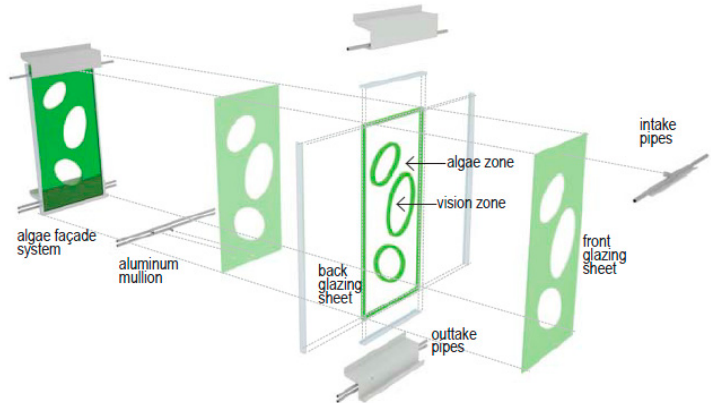
Figure 3. Algae façade system details [42]. Reproduced with the permission from author Kyoung-Hee